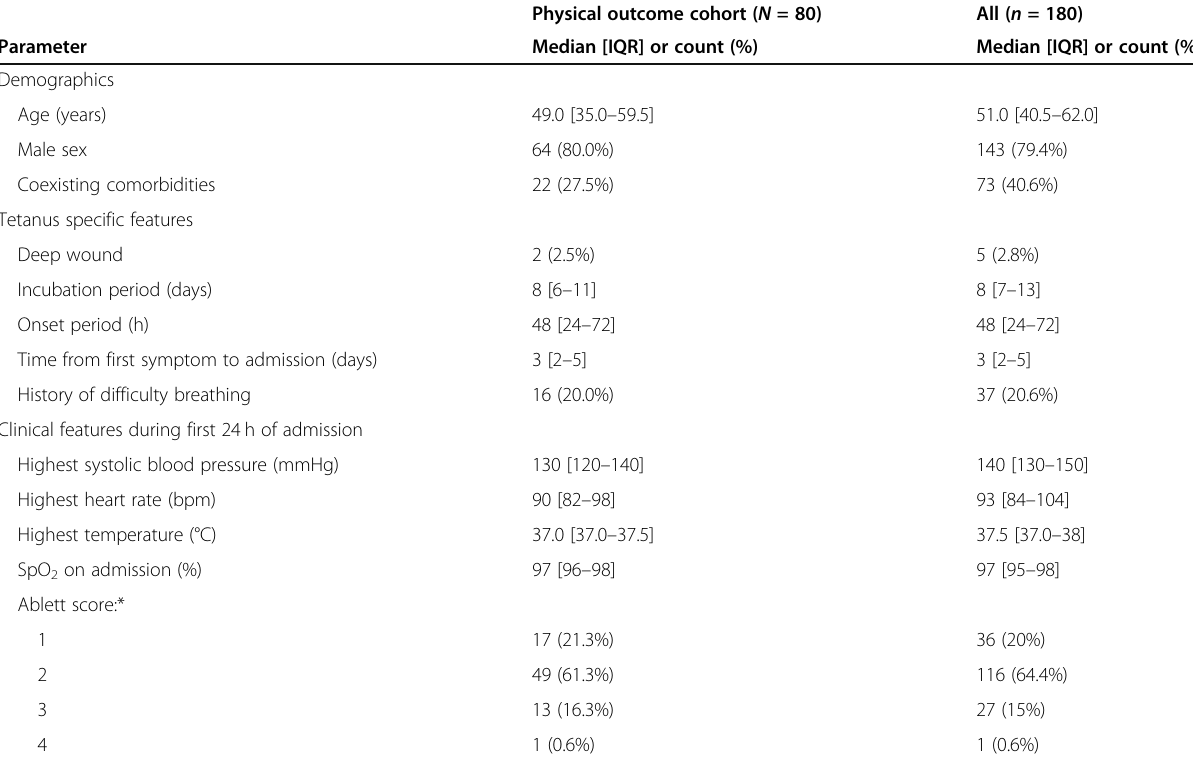
Table 1 Description of the demographic and clinical features of tetanus patients on admission to ICU Physical outcome cohort ( N =